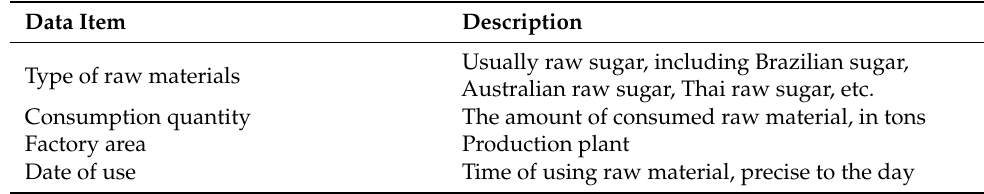
Table 2. Raw material consumption data set